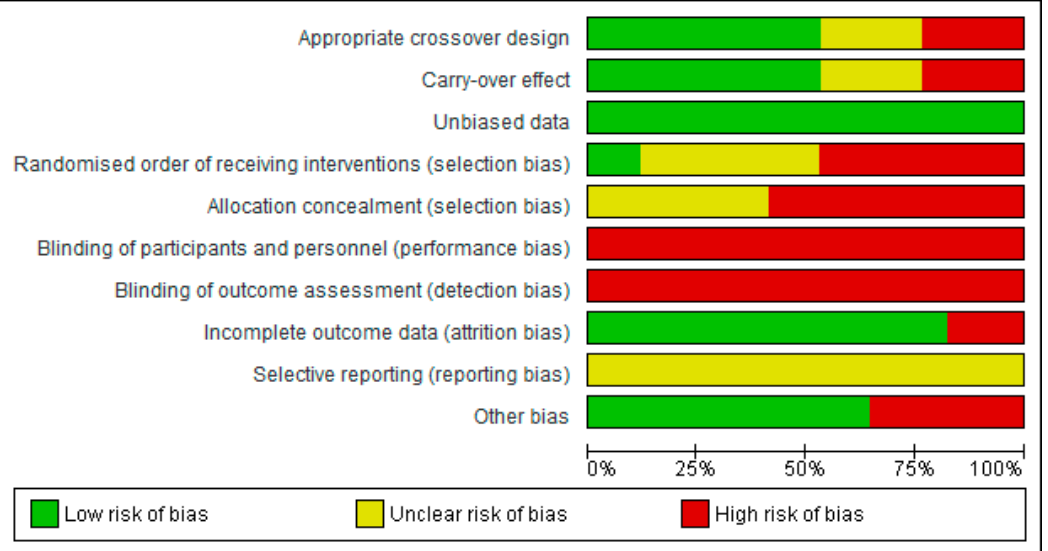
Figure 3. Risk of bias summary across acute crossover trials: review authors’ judgements about each risk of bias item for each included study.